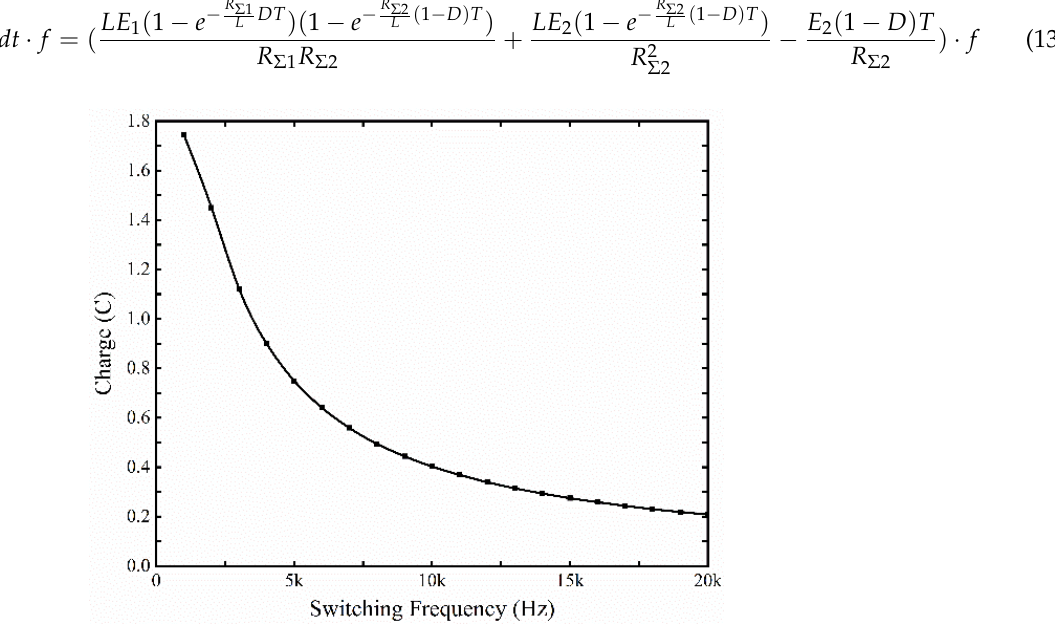
Figure 10. The amount of charge transferred to Cell2 at different switching frequencies. Figure 10 shows as the switching frequency increases, the amount of charge per unit time transferred to the target cell Cell2 decreases and tends to a certain limit. Therefore, from the point of view of increasing the equalization current and improving the time efficiency, the switching frequency should be chosen as a smaller